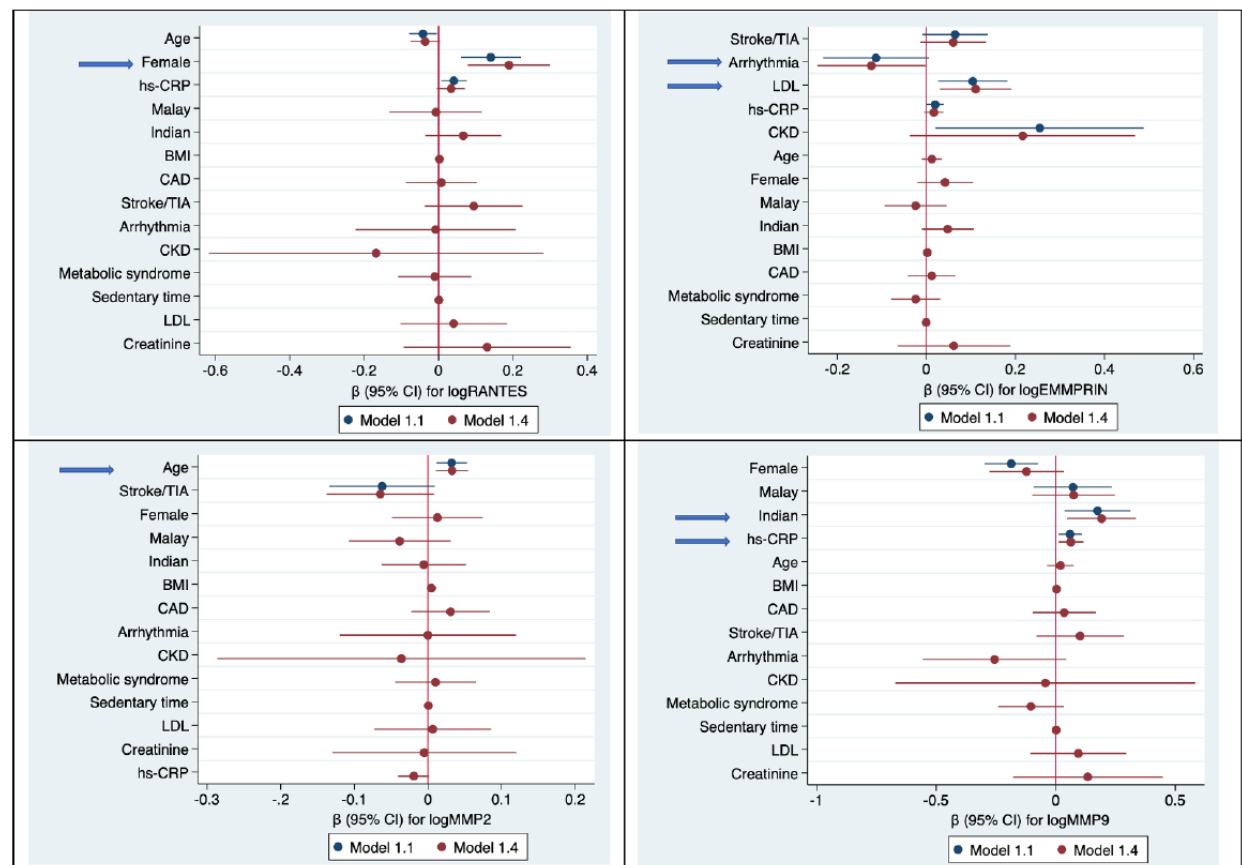
Figure 2. Forest plot for factors associated with the biomarkers.